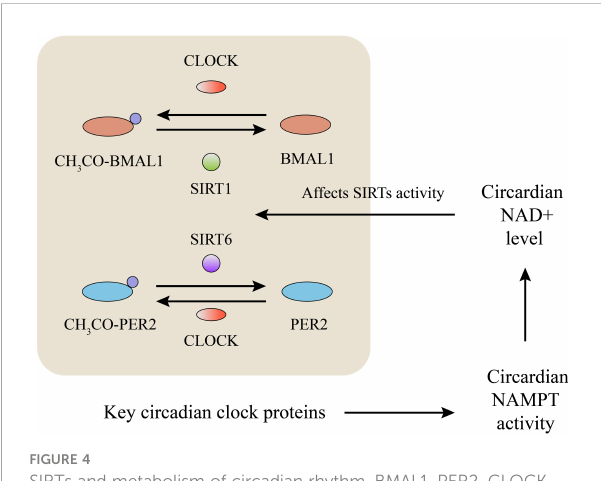
FIGURE 4 SIRTs and metabolism of circadian rhythm. BMAL1, PER2,